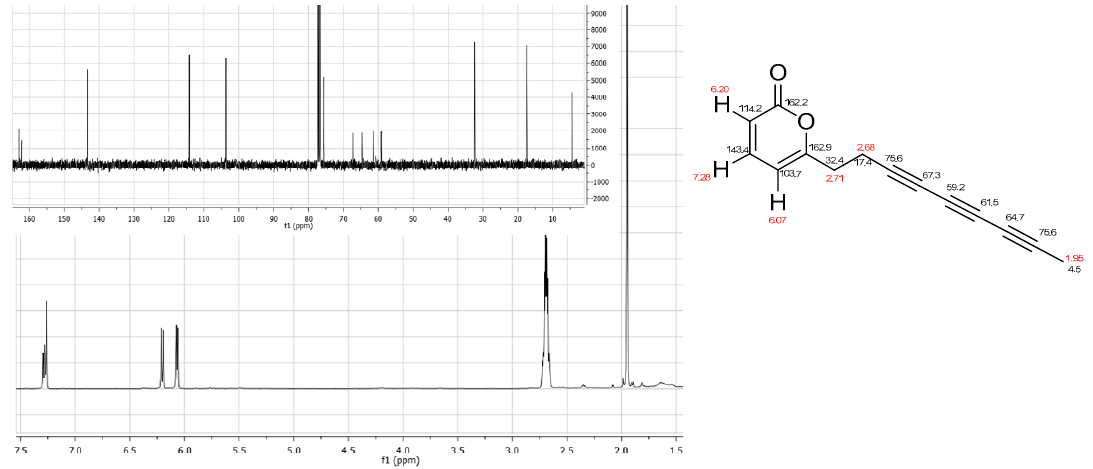
Figure 3. 1 H NMR ( bottom ) and 13 C NMR ( top ) spectra of Echinophorin D (structure with NMR assignments on the right). Table 1. 1 H and 13 C NMR data of Echinophorin D ( 3 ) a .